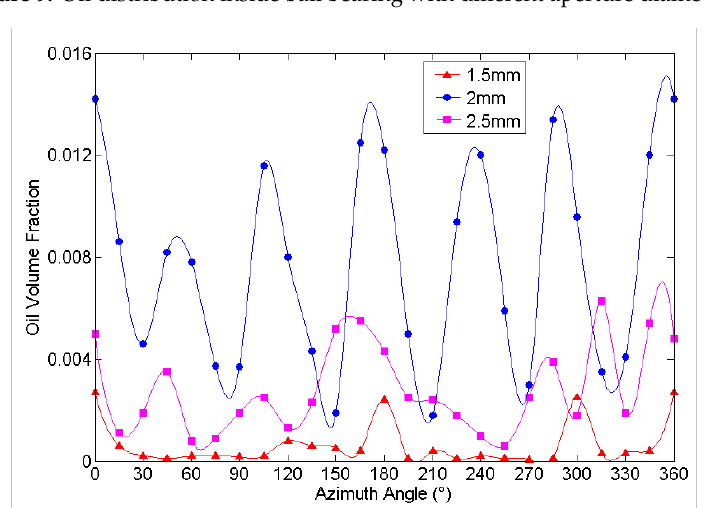
Figure 10. Oil volume fraction around the circumference with different aperture diameters.